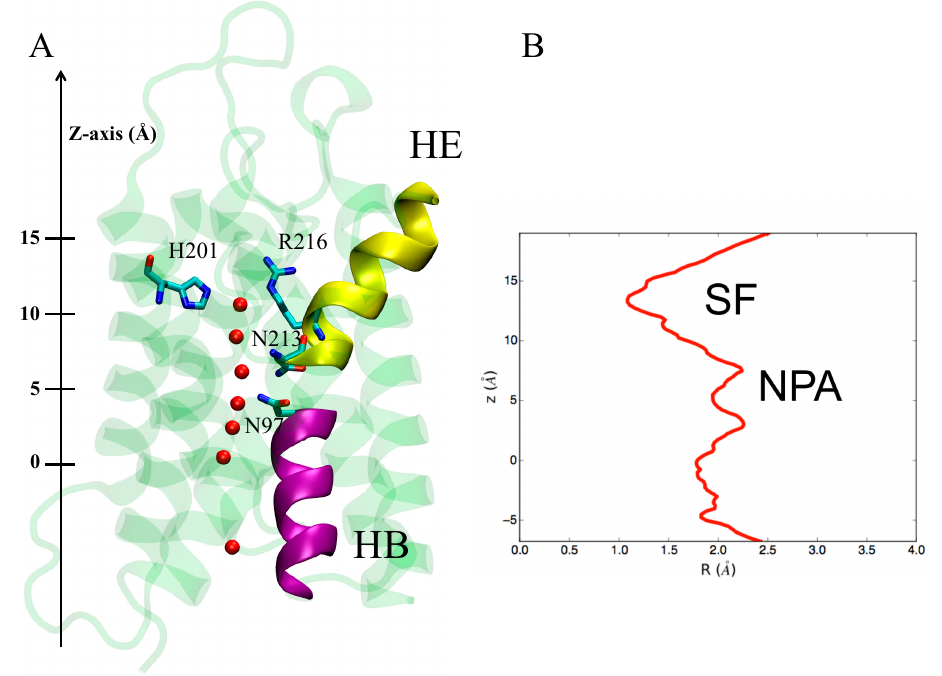
Figure 2. ( A ) X-ray structure of hAQP4. The X-ray solved structure of hAQP4 (PDB code 3GD8 [21]) is depicted as green cartoon representation. Important residues in the constricted selectivity filter (H201 and R216) and the asparagine residues belonging to the NPA motif regions are rendered as sticks. Water molecules inside the pore are shown as red spheres. The two short pore alpha helices responsible for an electrostatic barrier preventing proton conduction and named HE and HB are depicted as yellow and magenta cartoon representation respectively; ( B ) Pore radius. Pore radius R(Å) profile along the z-axis obtained from the hAQP4 X-ray structure using HOLE as cavity detection software (Department of Crystallography, Birkbeck Collage, University of London, London, UK)